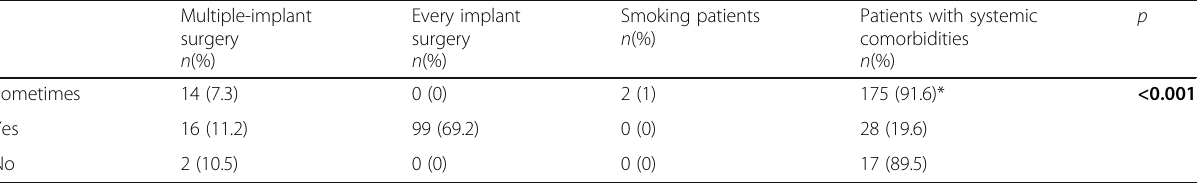
Table 6 The circumstances in which clinicians prefer to prescribe preoperative antibiotics Every implant Multiple-implant surgery